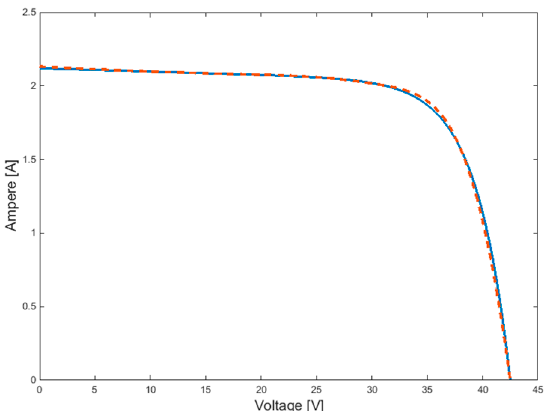
Figure 9. Current ‐ voltage (I ‐ V) curve for the photo ‐ voltaic (PV) module of Table 1 in environmental conditions (ECs) “Third” of the Table 2. I ‐ V curve of the proposed model (solid line) and I ‐ V curve of the datasheet (dotted line).